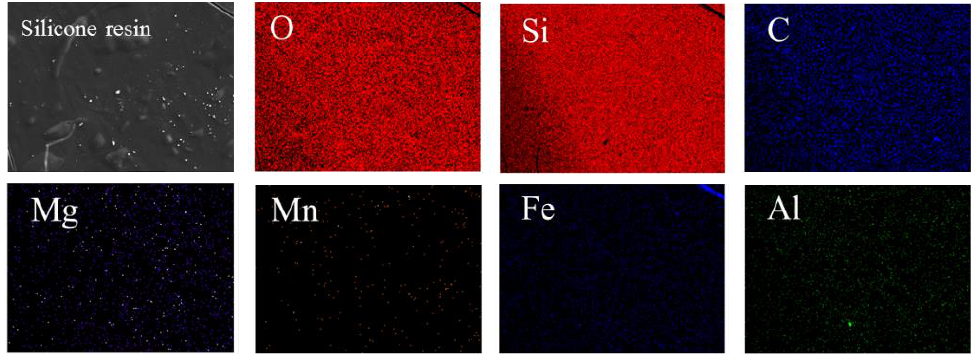
Figure 9. Elements maps of silicone resin.